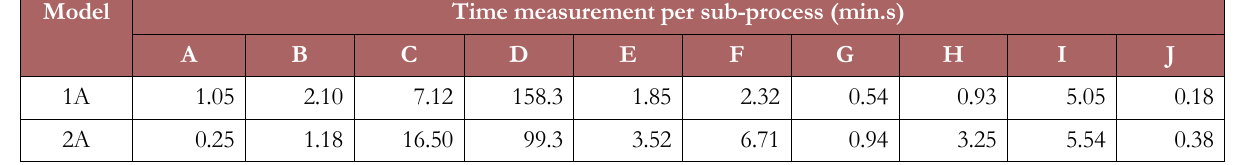
Table 20. Sets of time measurements per sub-process, for two bicycle models